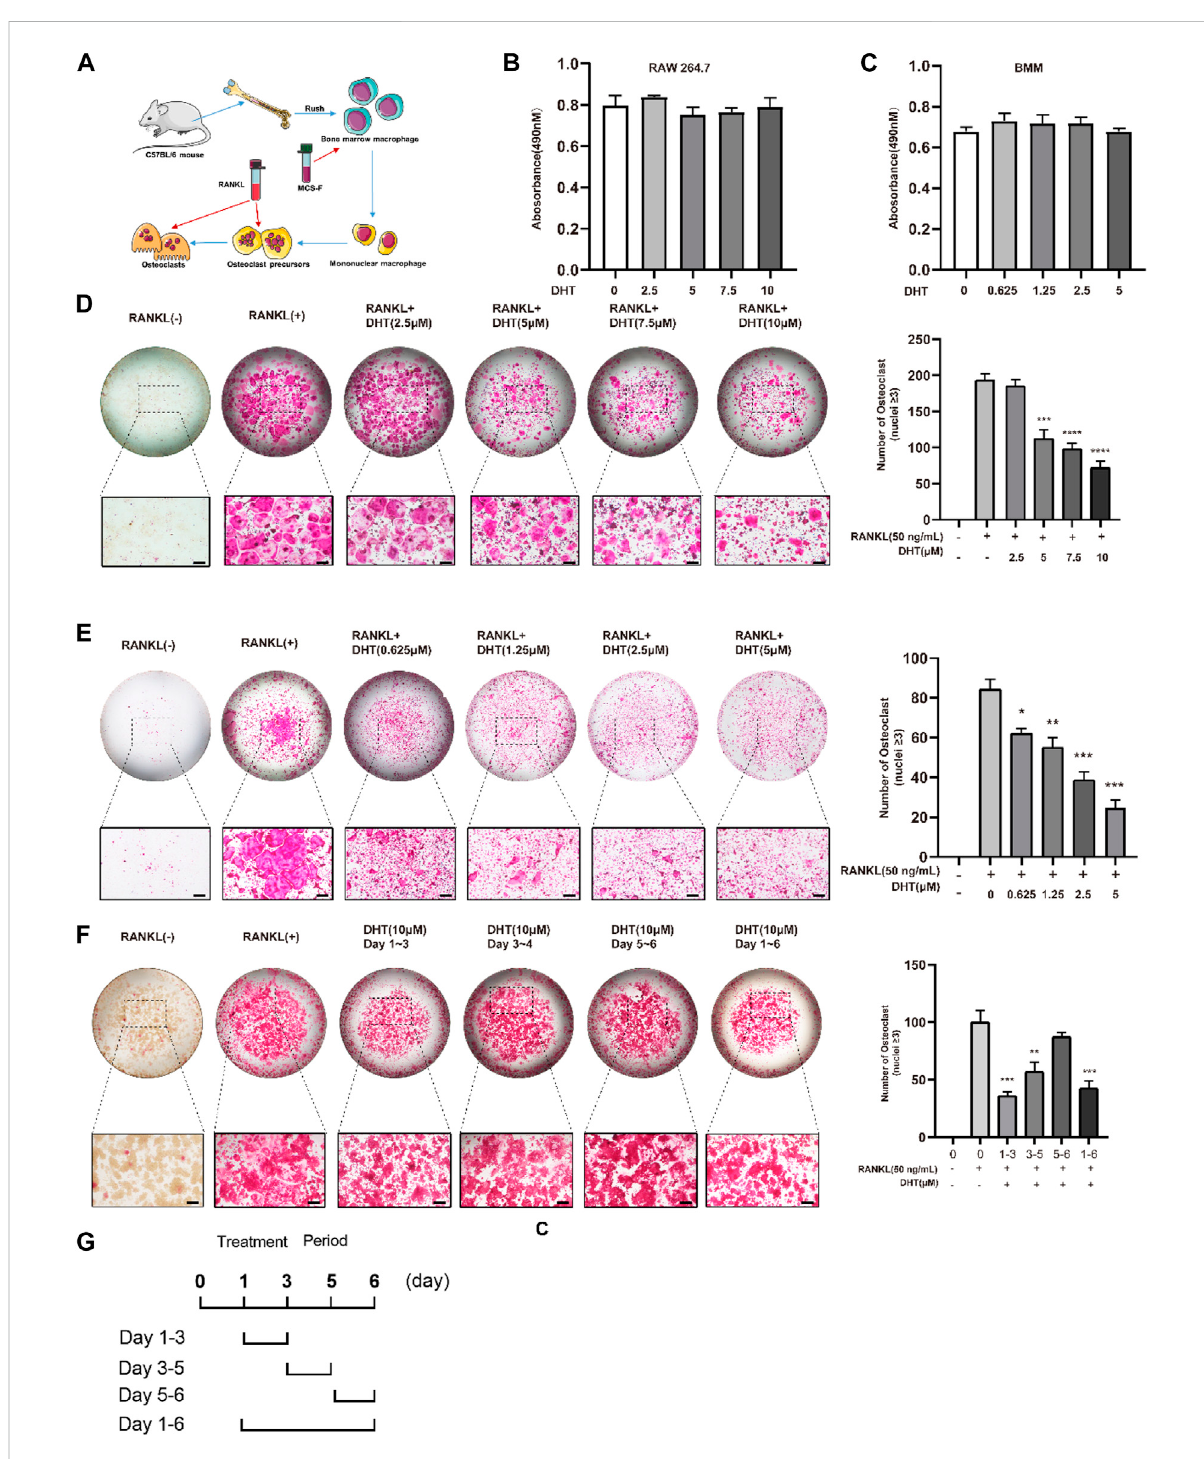
FIGURE 4 Dehydromiltirone (DHT) suppresses RANKL-induced osteoclastogenesis in vitro . (A) Schematic of osteoclast extraction, culture, and differentiation induction. (B,C) RAW264.7 and BMMs treated with different DHT concentrations were detected by the CCK-8 method. (D,E) Representative images of RAW264.7 cells and BMMs treated with various concentrations of DHT and the TRACP strains were obtained by light microscopy. (F,G) Stimulation with 10 μ M at different stages of osteoclast differentiation for 1 – 3, 3 – 4, 5 – 6, and 1 – 6 days and the statistical analysis. * p < 0.05, * *p < 0.01, ***p < 0.001, ****p < 0.0001 relative to the control group. Scale Bar = 200 μ